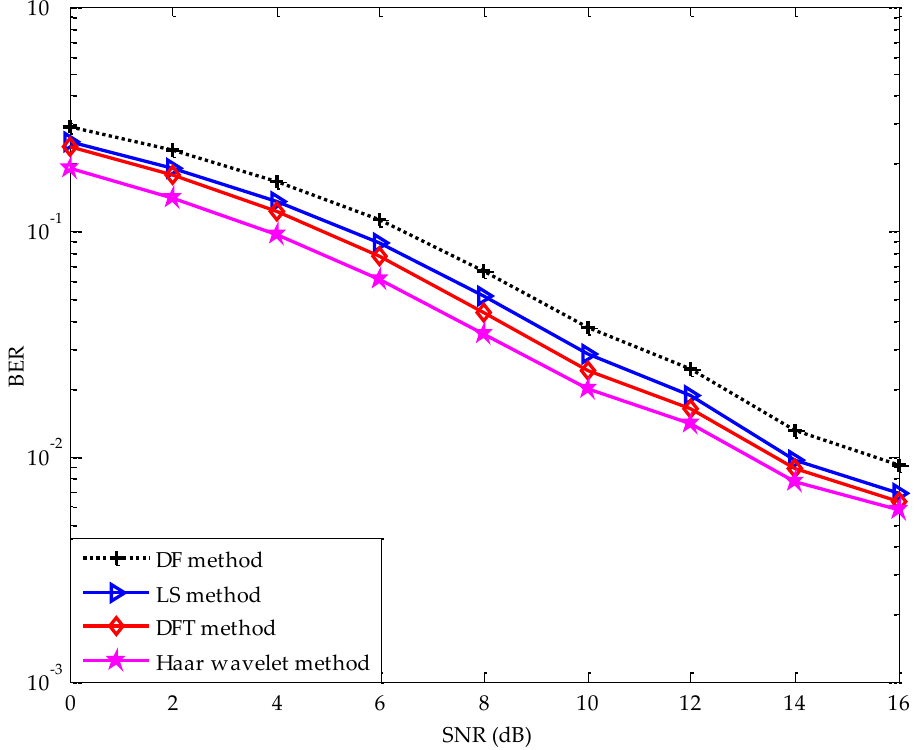
Figure 10. BER performance of QPSK modulated CP-OFDM and wavelet-OFDM systems under CDT1 channel with Doppler spread 20Hz.